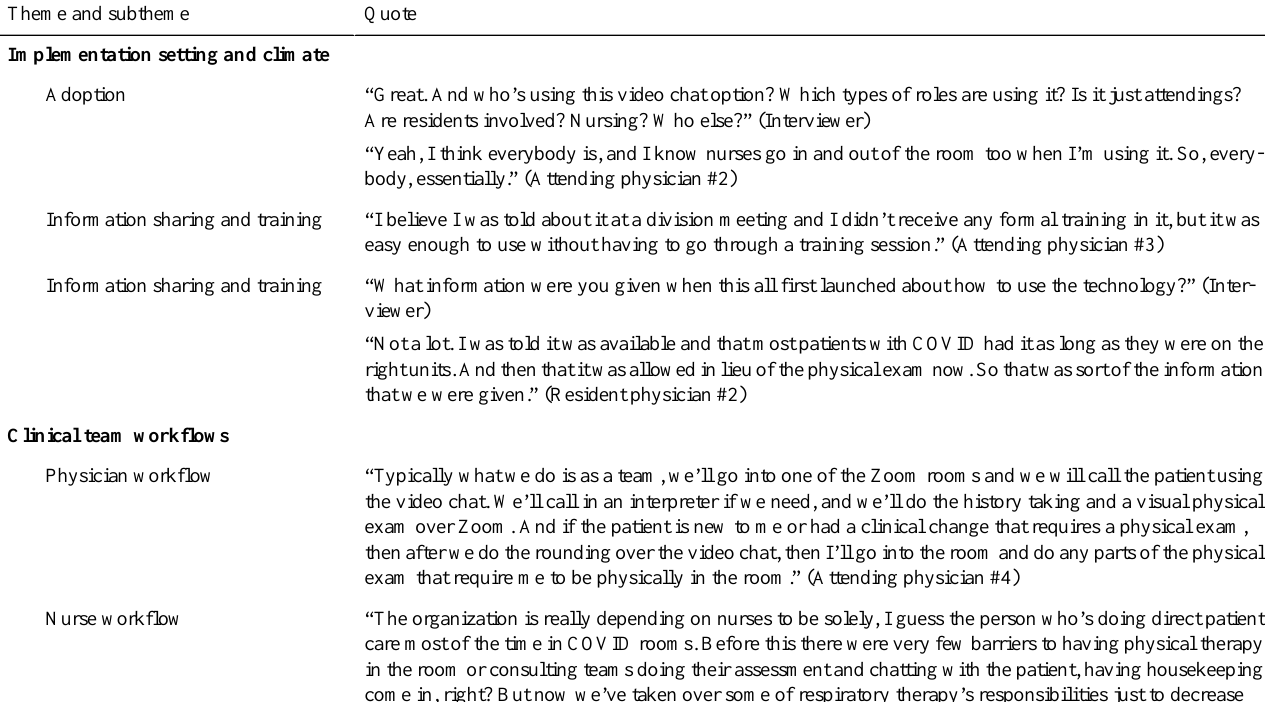
Table 1. Qualitative results by theme and subtheme and example quotes. QuoteTheme and subtheme Implementation setting and